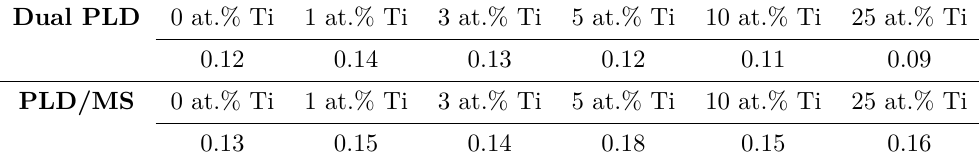
different places. For each liquid, a new sample was used. From each droplet, series of 15 pictures were evaluated. Laplace profile fitting was used. Tested samples were on Si (100) and thickness of the films was around 100